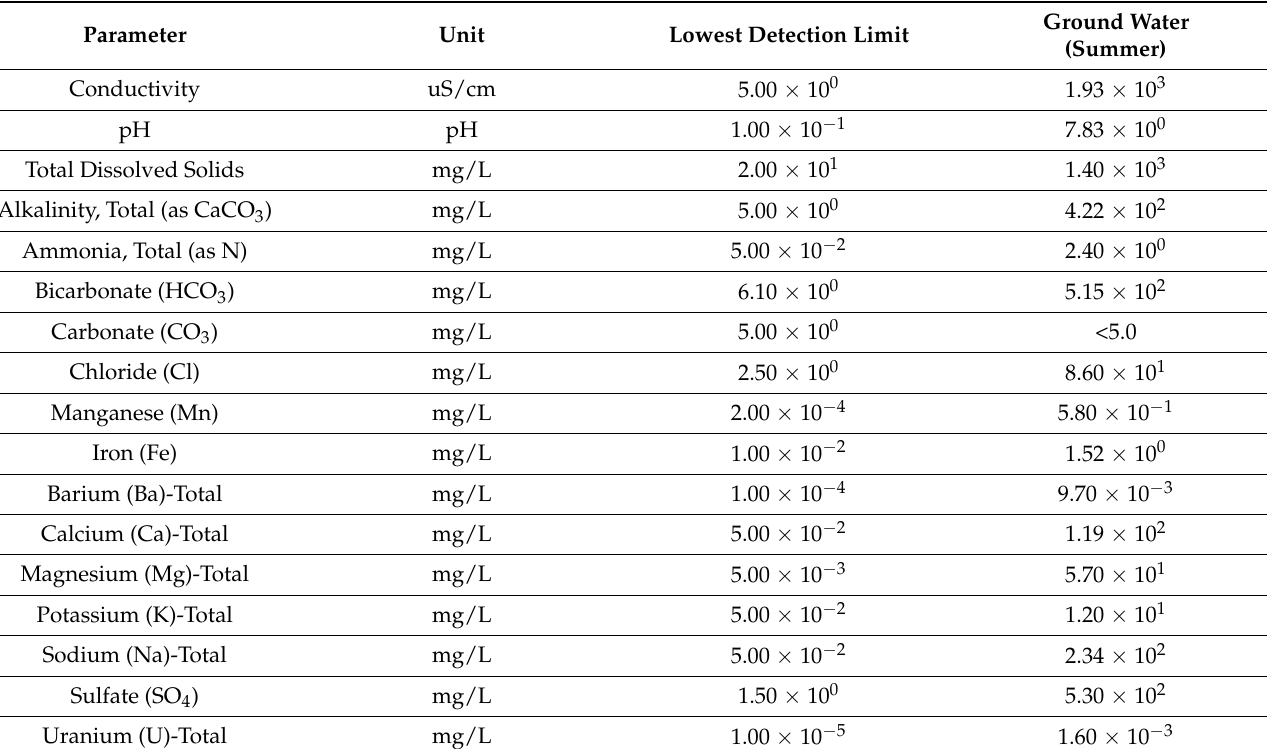
Table 1. Hatfield aquifer source water